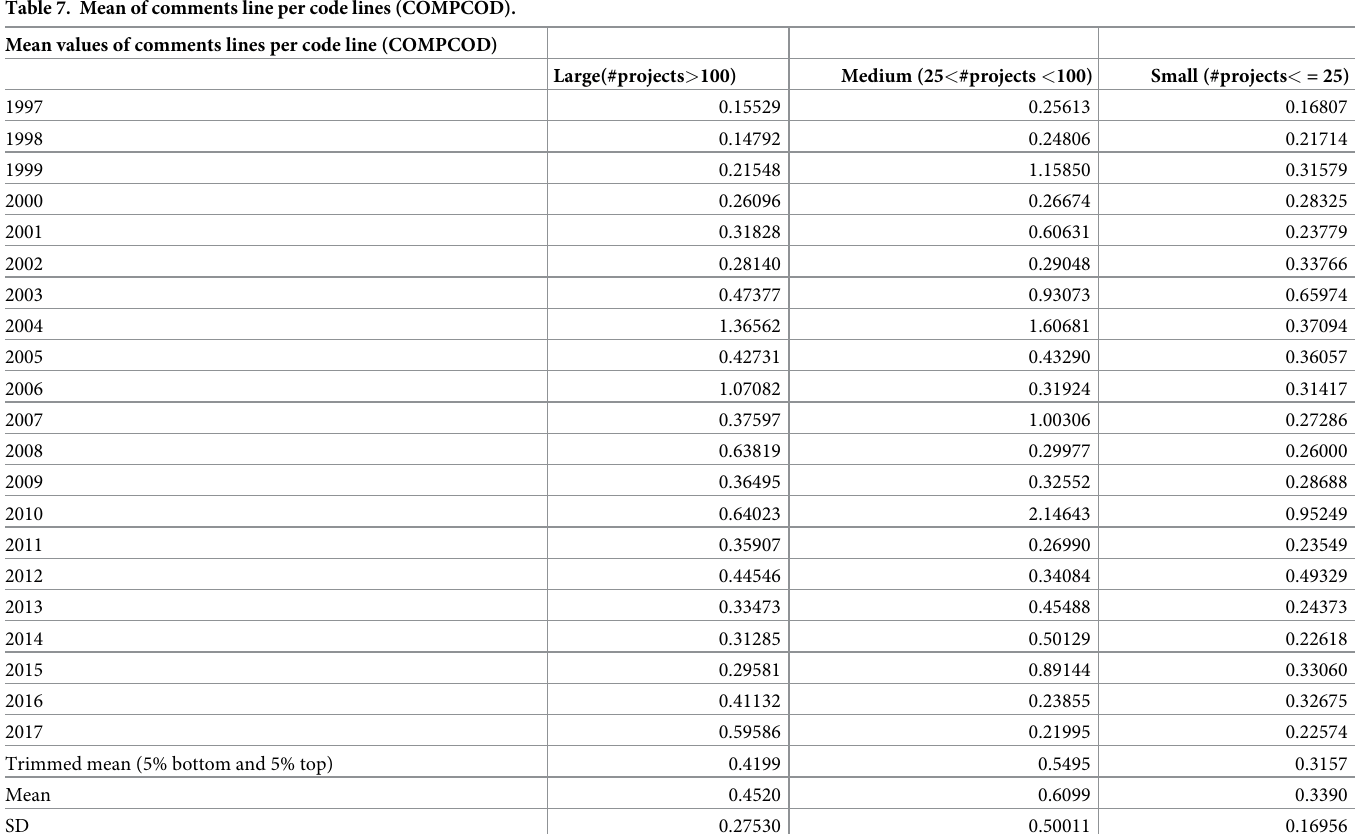
Table 7. Mean of comments line per code lines